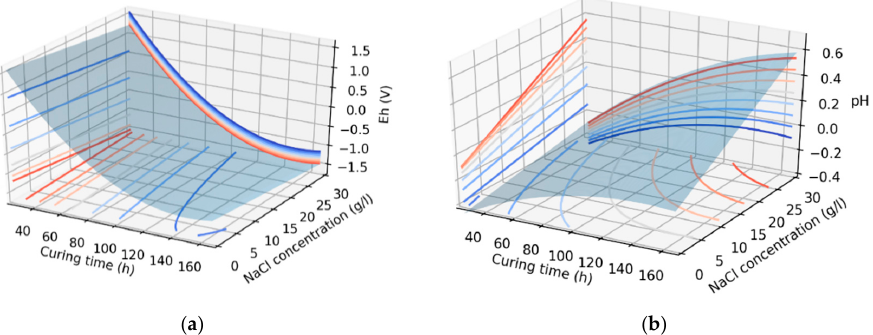
Figure 9. Surface plot for Eh ( a ) and pH ( b ) in function of different levels of curing time and NaCl concentration. NaCl